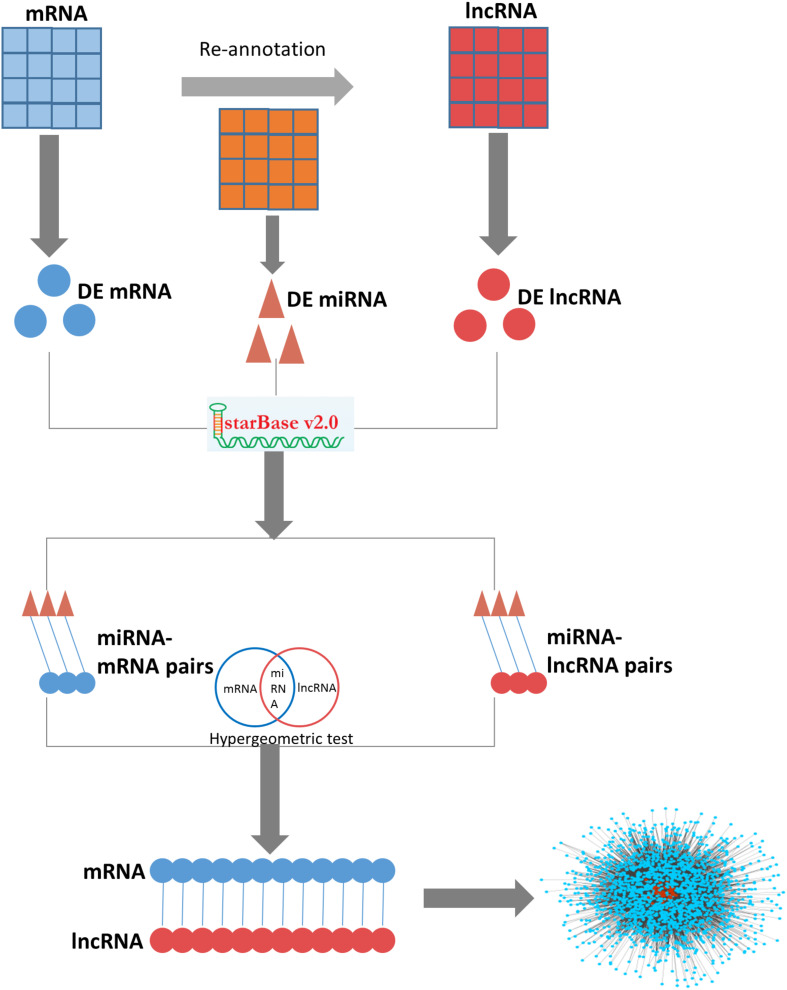
The pipeline for construction of the ovarian endometriosis-related ceRNA network.